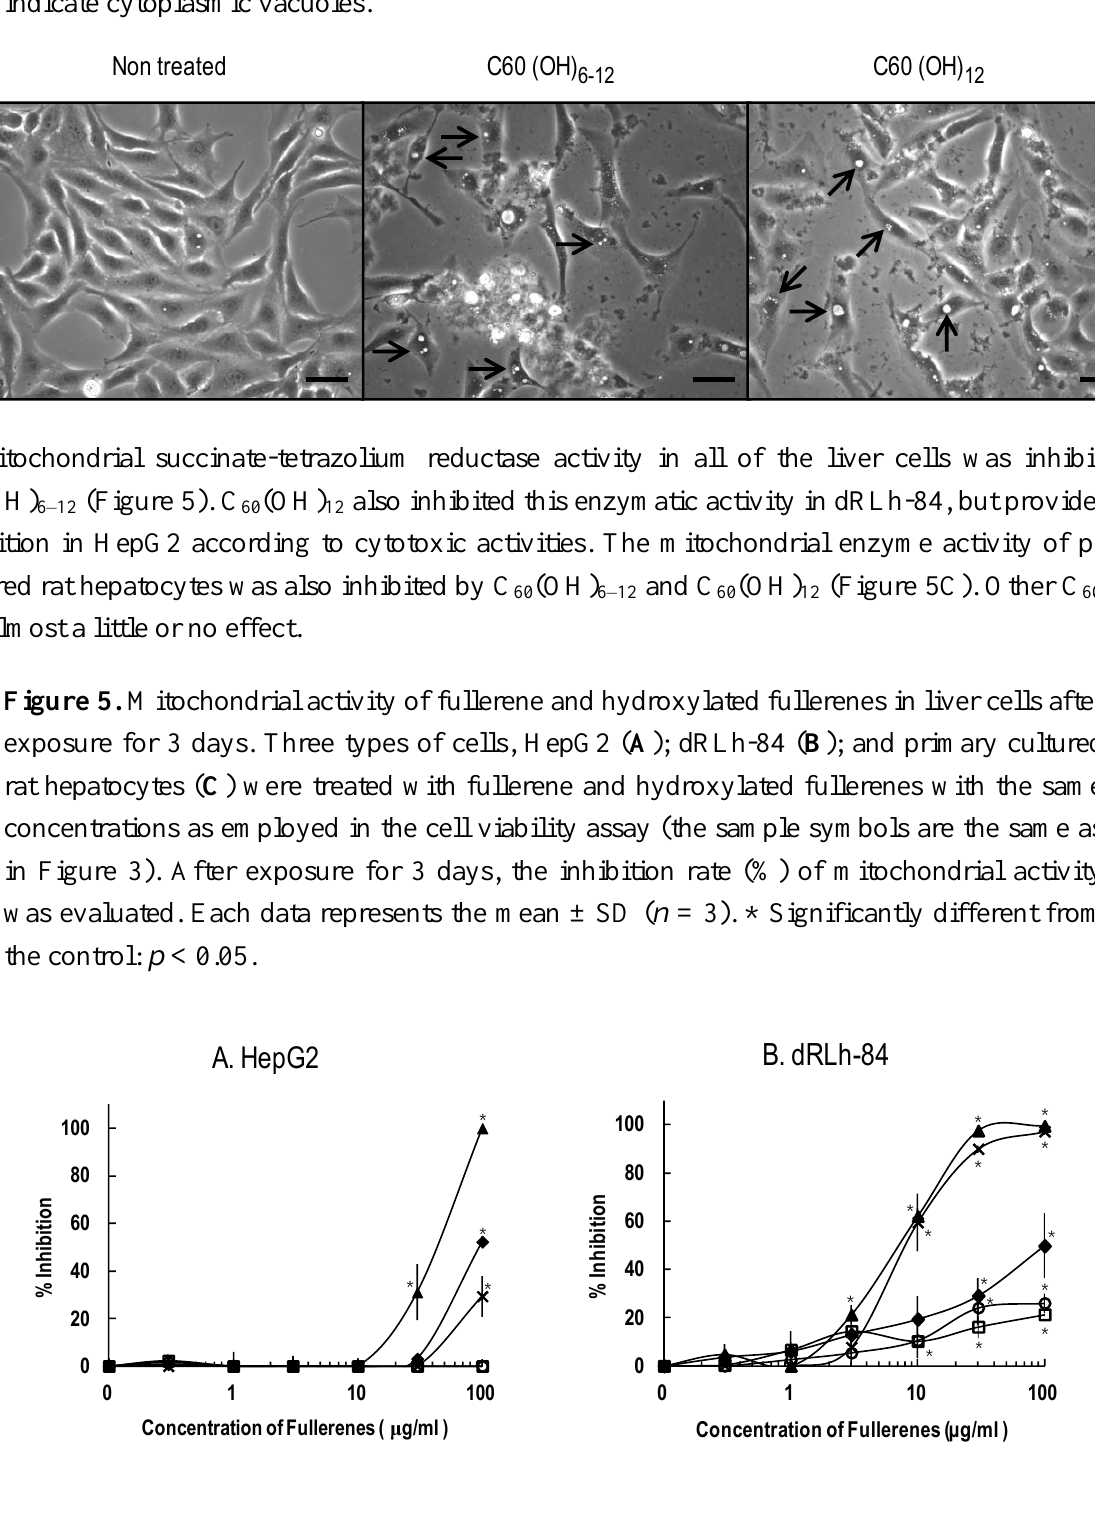
indicate cytoplasmic vacuoles.